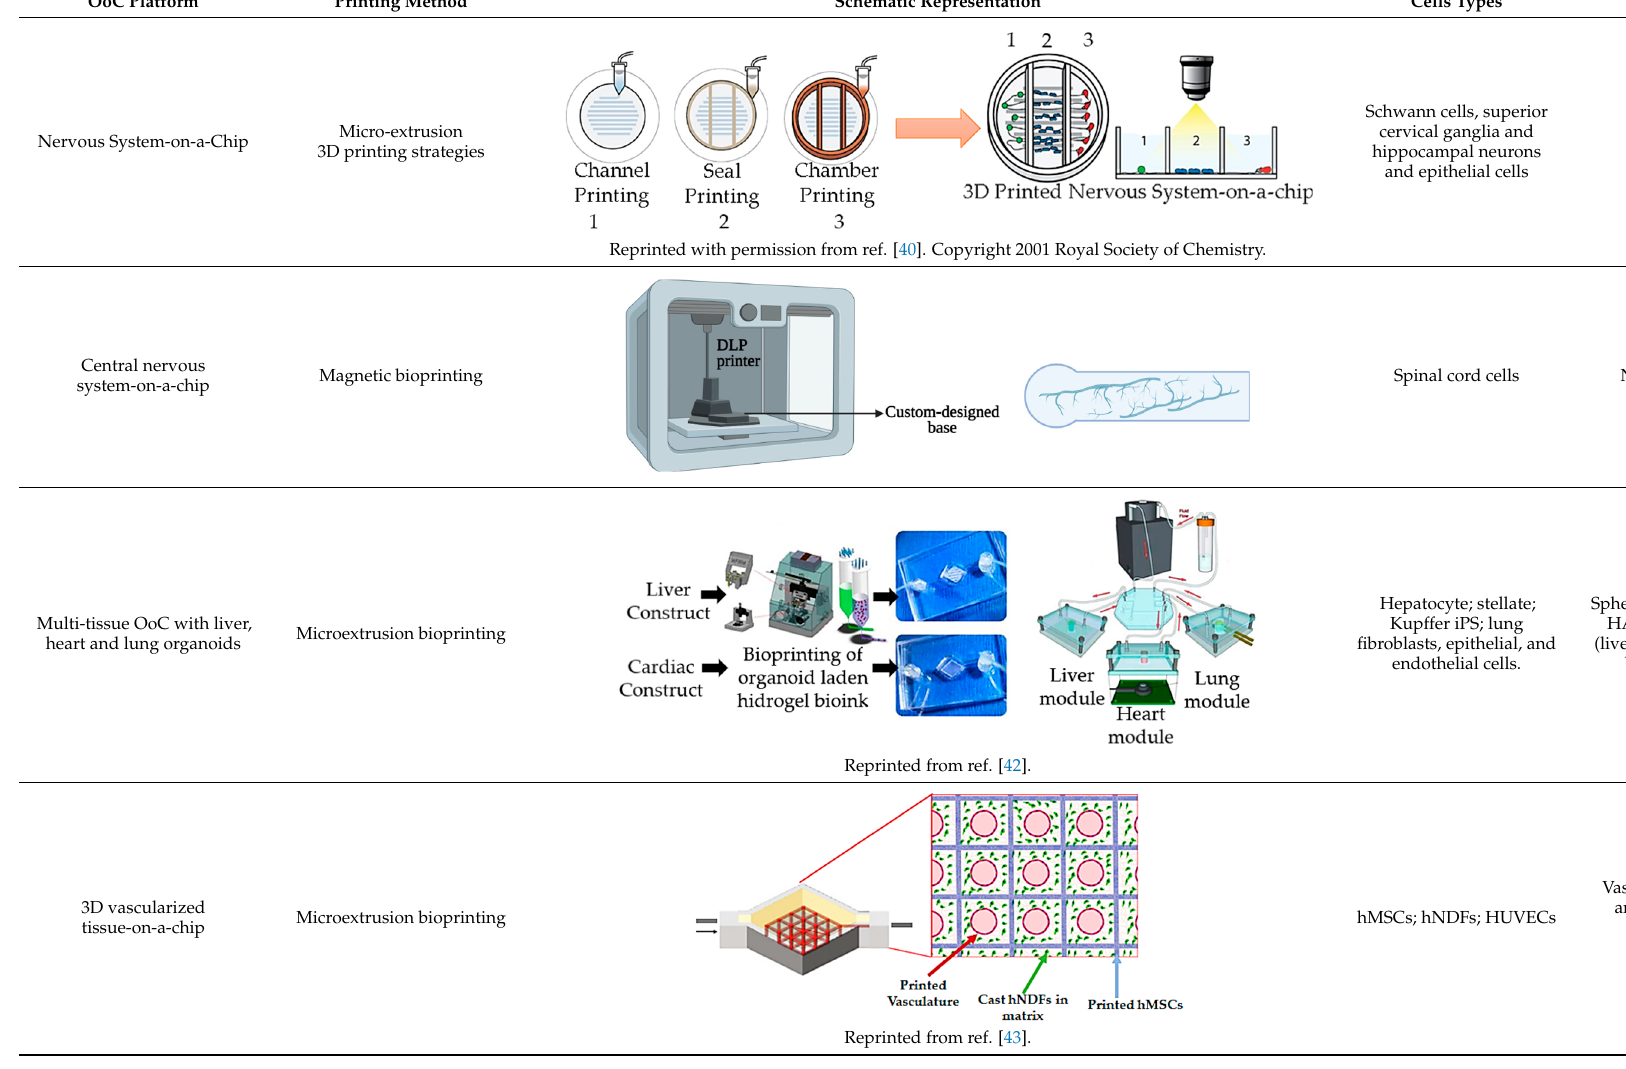
Table 2. 3D bioprinting techniques used to fabricate OoC platforms.